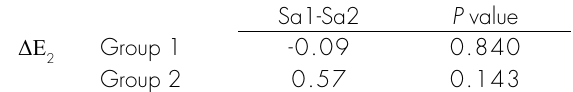
Table VI. Correlation between colour change and difference in surface roughness between T1 and T2 (N = 16)( p <